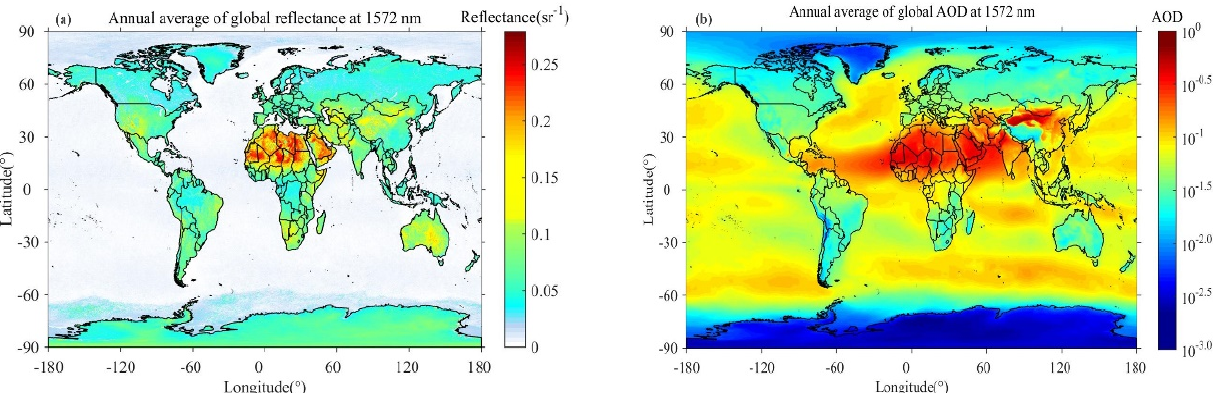
Figure 3. ( a ) Annual average of global surface reflectance in 2018. ( b ) Annual average of global aerosols optical depth (AOD) in 2018.